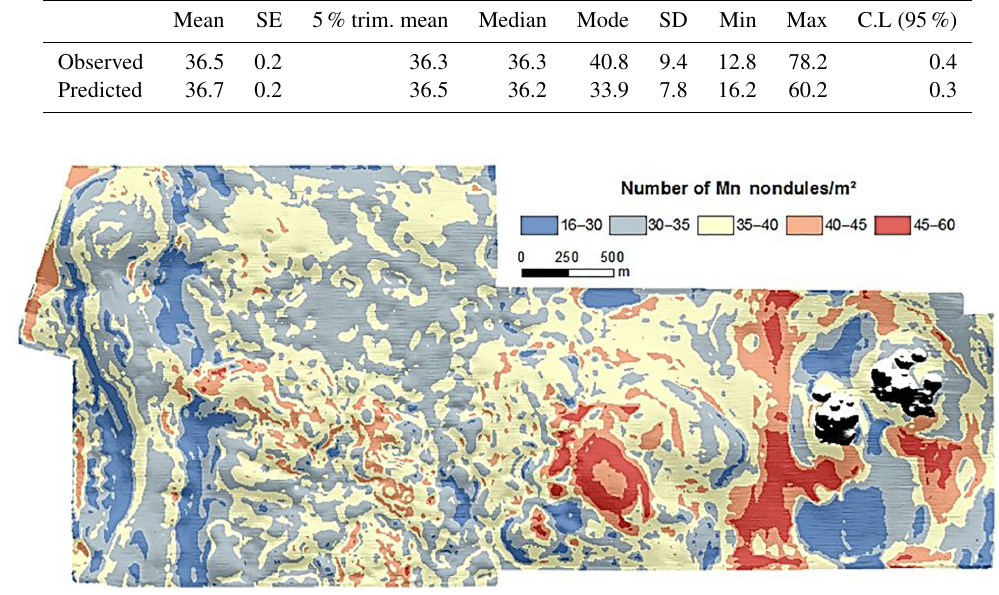
Figure 13. The RF-predicted distribution of Mn nodules m − 2 inside block G77.